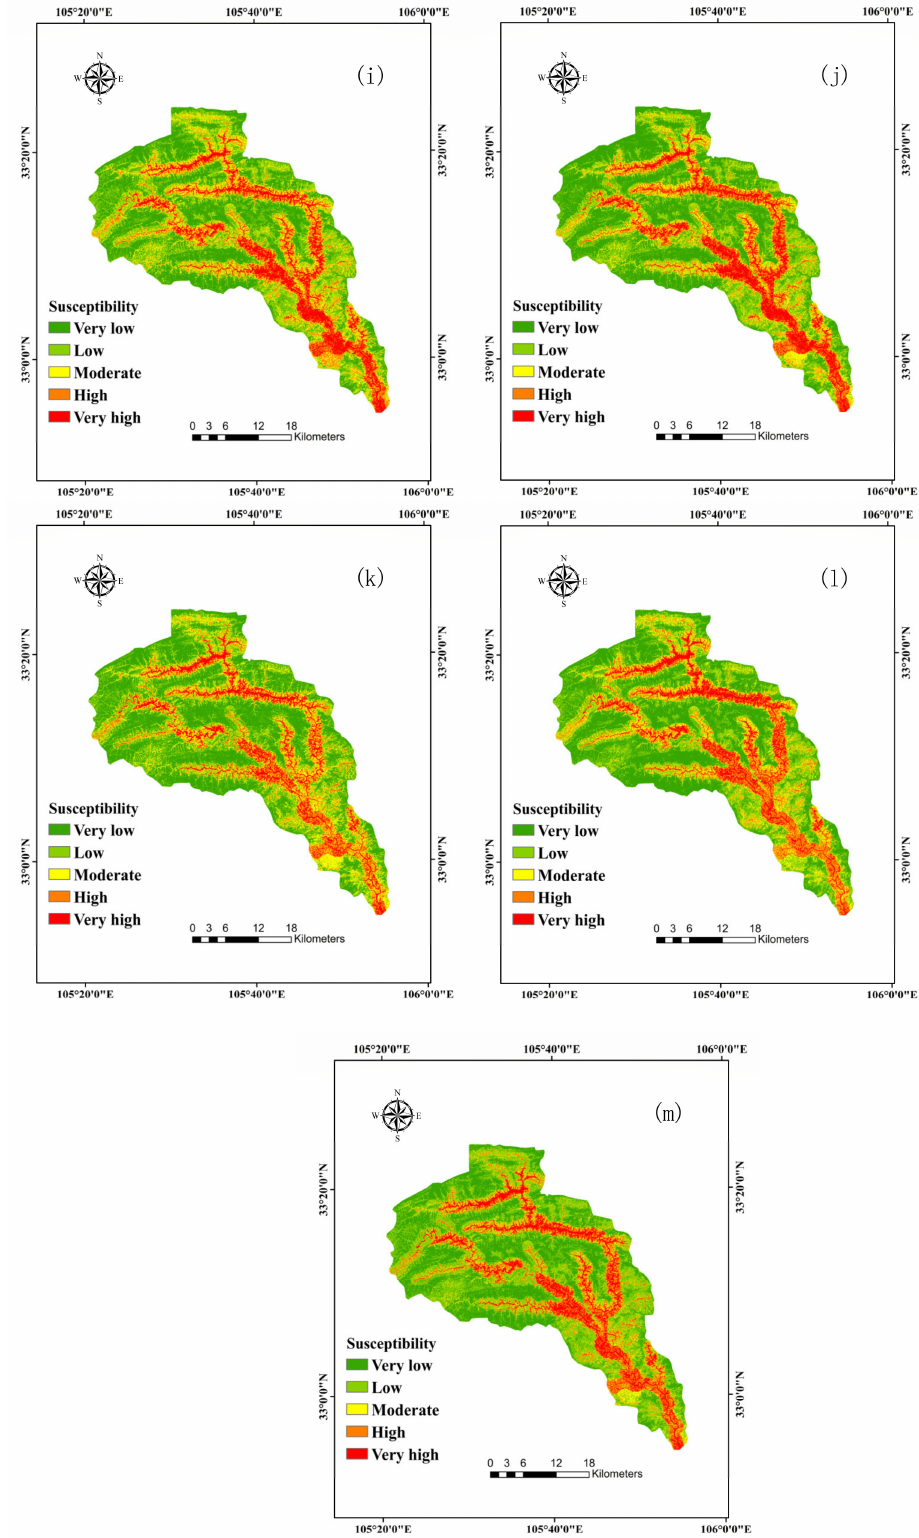
Figure 9. The multiple geological hazard susceptibility maps: Maps ( a )–( m ) correspond to weighting schemes a to